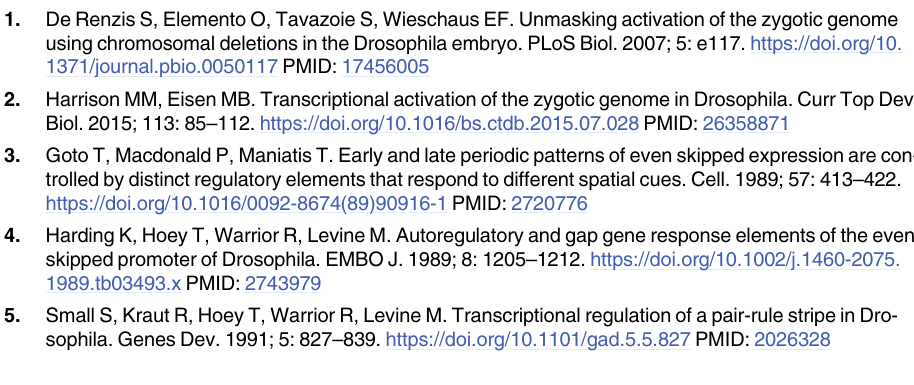
axis represents a single gene. (TIF) S10 Fig. Plots of log(scvi normalized expression) of select (A) Antennapedia complex genes: Dfd (top), Scr (middle), and Antp (bottom) and (B) Bithorax complex genes: abd-A (top) and Abd-B (bottom) in each cluster (left) and in bulk (right) for control (teal) and dCTCF mat-/- nuclei (pink). Asterisks indicate statistically significant differential expression (absolute value of expression > = 1.5 and Bonferroni corrected p-value < 0.05).